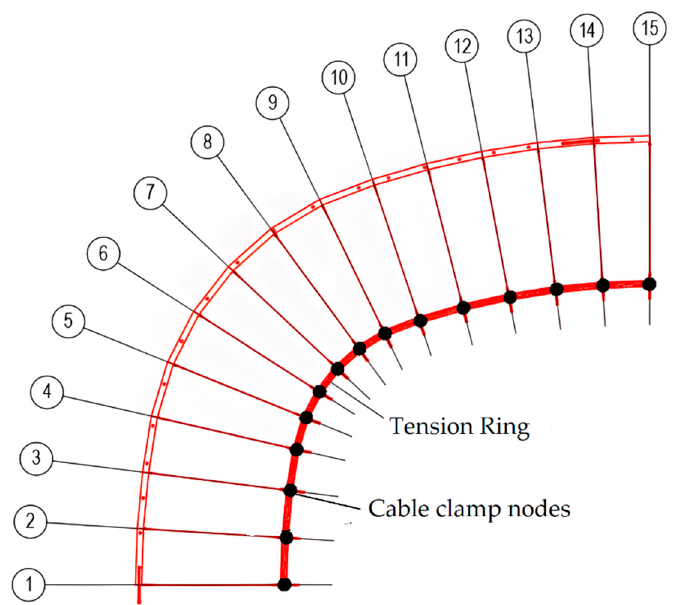
Figure 50. Tension ring clamp nodes. (1~15 represent the tension ring cable clamps’ nodes NO. corresponding to the axis.)